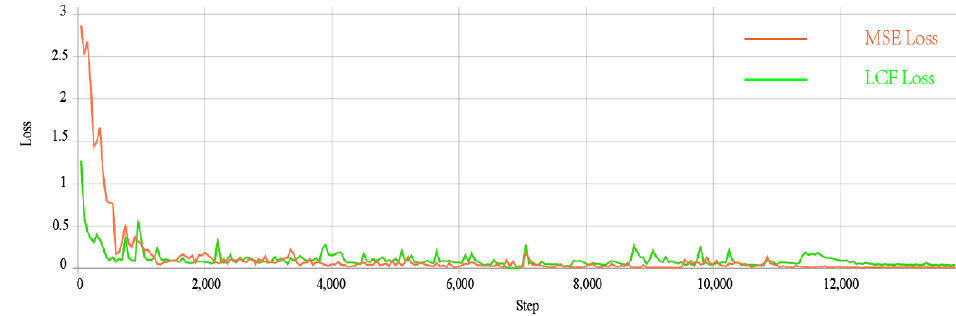
Figure 8. Comparison on different loss